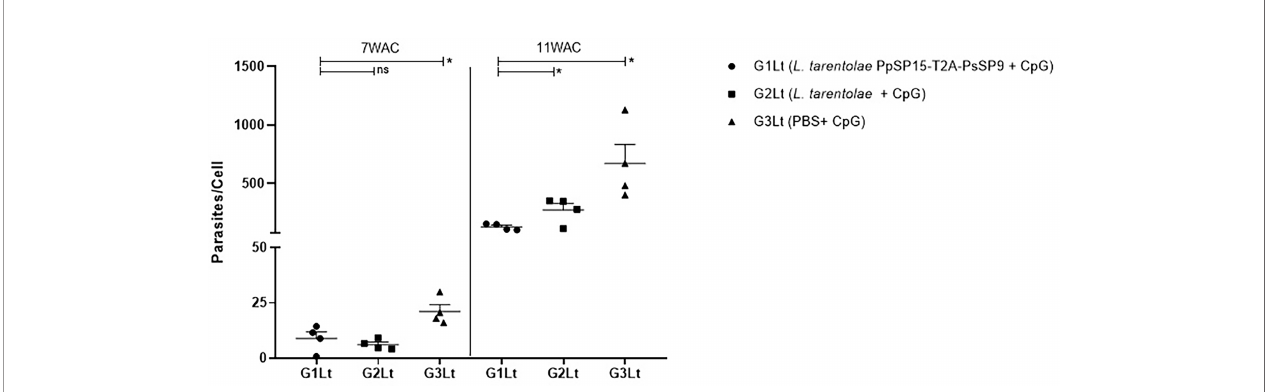
FIGURE 7 | Assessment of parasite load in vaccinated and control BALB/c mice infected with L. tropica +SGH. Pre-treated BALB/c mice (n=28 per group) with CpG were immunized at the left footpad with L. tarentolae PpSP15-T2A-PsSP9 (G1), L. tarentolae wild-type (G2), and PBS (G3). Three weeks after the last booster, mice were challenged with L. tropica metacyclic promastigotes plus Ph. sergenti SGH in the contralateral footpad. The number of parasites per mouse lymph node cell was determined at weeks 7 and 11 post-infection by Real-Time PCR (n=4 mice per group). Results are exhibited as the mean ± SE. Data are representative of two independent experiments. Student t-test was used for statistical analysis * p< 0.05; ns, non-signi fi